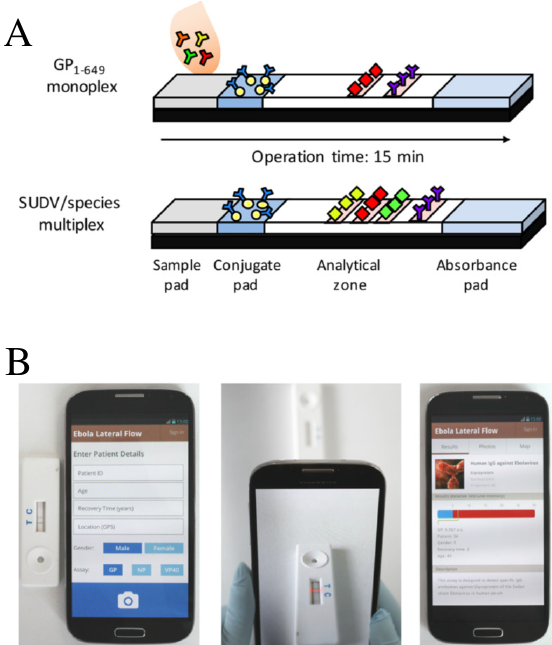
Figure 9. ( A ) schematics of monoplex and multiplex immunochromatographic strip configuration to detect Ebola virus. ( B ) Illustration of a smartphone application for a rapid, robust, simple, and portable device for the analysis of the strip results. A summary of the patient details can also be provided in this approach. Reproduced with permission from Brangel, P.; Sobarzo, A.; Parolo, C.; Miller, B.S.; Howes, P.D.; Gelkop, S.; Lutwama, J.J.; Dye, J.M.; McKendry, R.A.; Lobel, L.; Stevens, M.M. A Serological Point-of-Care Test for the Detection of IgG Antibodies against Ebola Virus in Human Survivors. ACS Nano 2018 , 12, 63-73 [90], which can be found at https://pubs.acs.org/doi/full/10. 1021/acsnano.7b07021. Any requests for further permissions related to the material excerpted should be directed to the American Chemical Society.